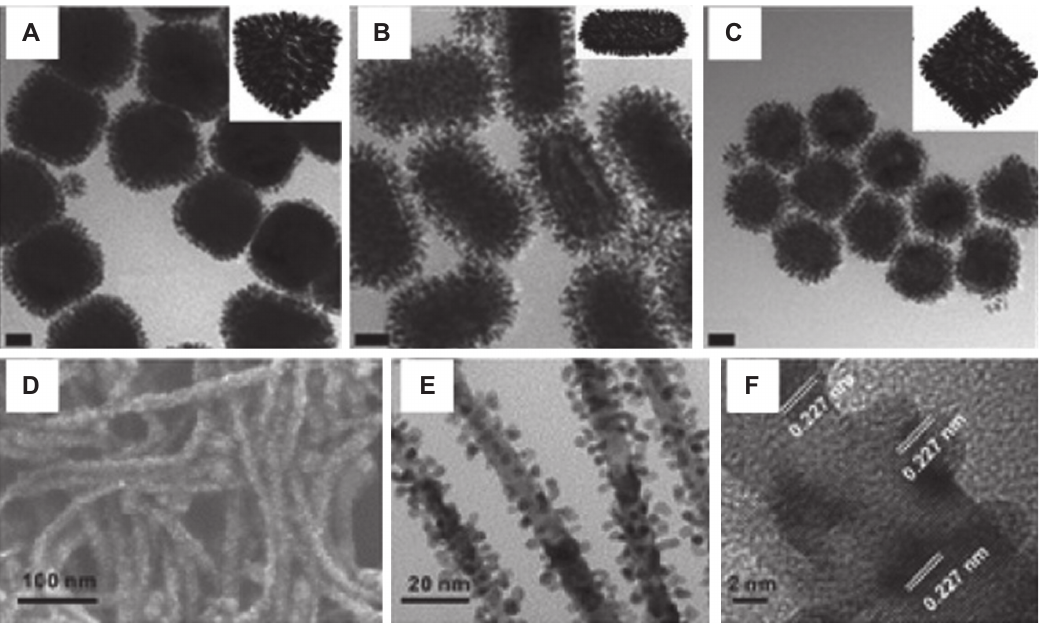
Figure 4 (A–C) Au@Pt dendritic core-shell structures using Au nanocubes, nanorods, and octahedra as seeds, respectively. Scale bars are 20 nm. Adapted with permission from Ref. [31]. Copyright 2010 Wiley. (D–F) Au/Pt nanowires with dendritic Pt shell on Au nanowires. Adapted with permission from Ref. [30]. Copyright 2011 The Royal Society of